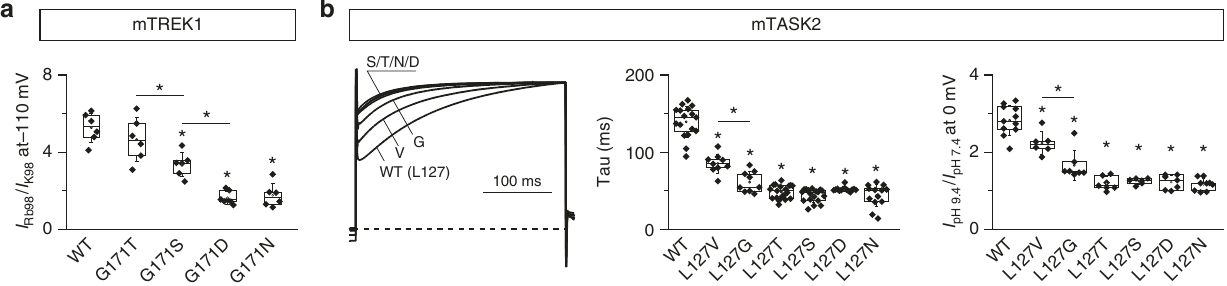
Fig. 5 Gradual activation of TREK1 and TASK2 by a series of TM2.6 mutations. a Response of different TREK1 TM2.6 mutants to rubidium/potassium ion substitution. Ratios of whole-cell currents recorded at − 110 mV for [Rb + ] o 98 mM and [K + ] o 98 mM. b Gradual increase of TASK2 activation kinetics and response to pH challenge for different TM2.6 mutants. Normalized current traces recorded at + 40 mV (left panel) and corresponding activation constants (Tau (ms), middle panel). Ratios of whole-cell current recorded at 0 mV with extracellular pH 9.4 and pH 7.4 (right panel). Currents were recorded 24 h after injection of cRNA at 1 ng/oocyte. Each data point represents one oocyte; center lines, medians; open circles, means; box limits, 25th and 75th percentiles; whiskers, standard deviation. ANOVA, Tukey ’ s multiple comparison test, * p <